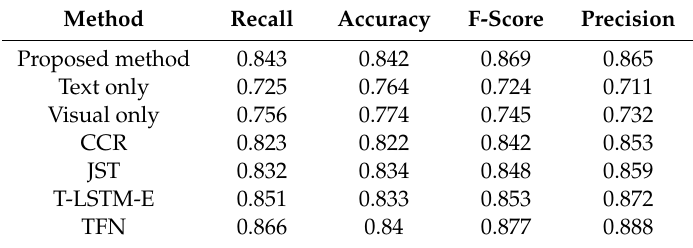
Table 4. Performance of various sentiment analysis methods on